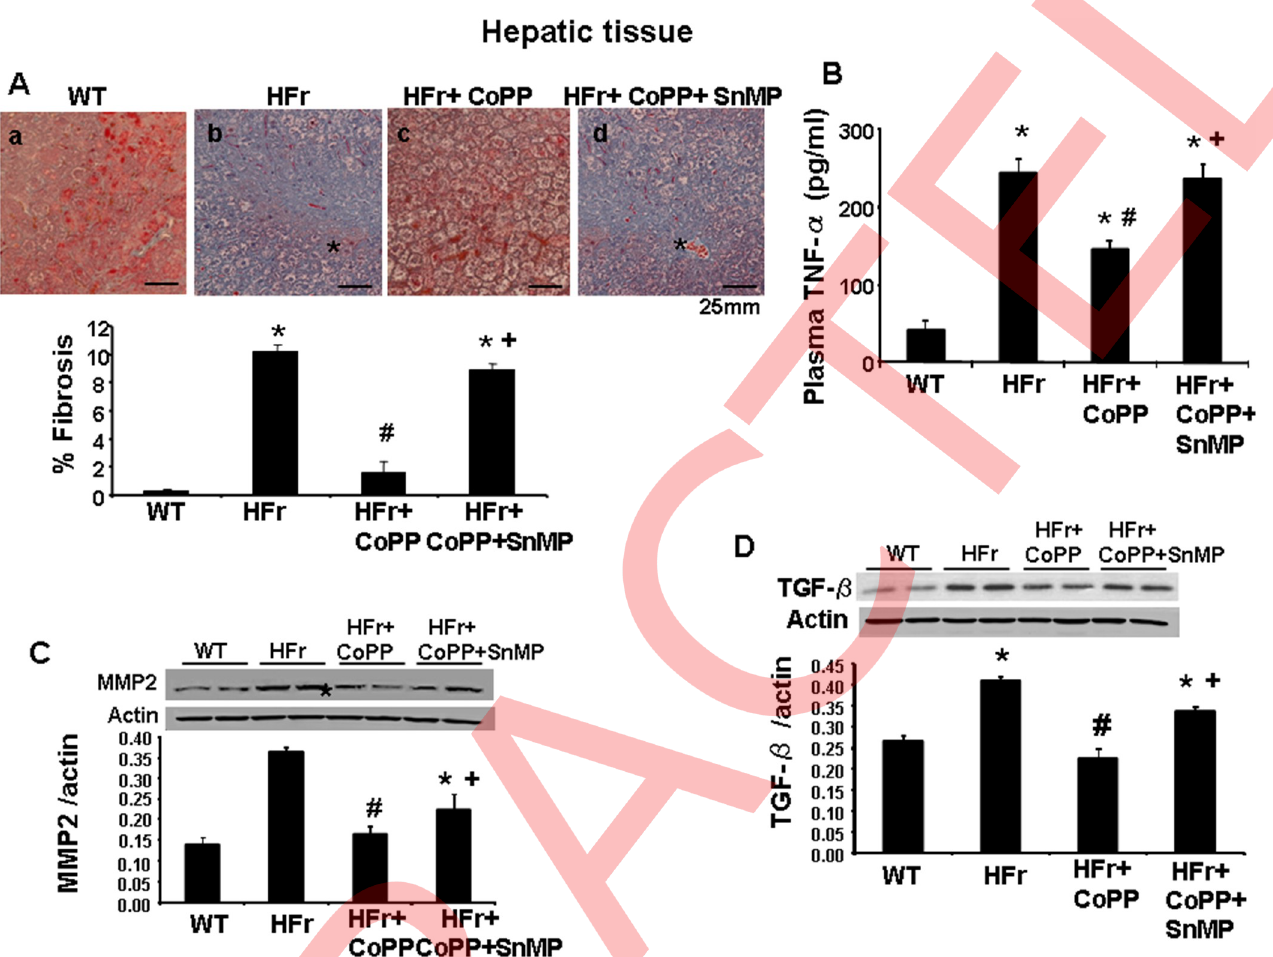
Fig 7. Effect of induction of HO-1 (CoPP) and inhibition of HO (SnMP) on hepatic fibrosis, markers of hepatic fibrosis in mice fed high-fructose diet for 20 weeks. (A) Masson’s trichrome staining in liver and quantitative analysis of WT, high fructose, high fructose treated with CoPP, and high fructose treated with CoPP and SnMP, magnifications: 40 × (n = 4) ( � Indicates fibrosis). A representative section for each group is shown. (B) Plasma TNF α levels. (C) MMP2 protein expression and (D) TGF β protein expression on western blot analysis. Data are shown as mean band density normalized to β -actin. Results are mean ± SE, n = 4/group. � p < 0.05 vs CTR; # p < 0.05 vs HFr, + p < 0.05 vs HFr+CoPP. Fig 7C Actin panel is excluded from this article’s CC-BY license. See the accompanying retraction notice for more information.